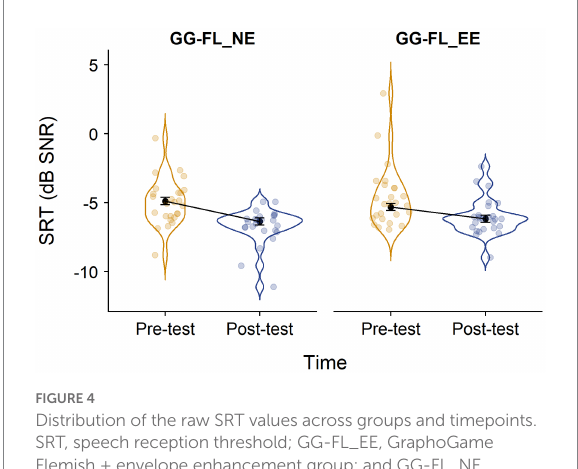
FIGURE 4 Distribution of the raw SRT values across groups and timepoints. SRT, speech reception threshold; GG-FL_EE, GraphoGame Flemish + envelope enhancement group; and GG-FL_NE, GraphoGame Flemish + non-enhanced group. Black dots and error bars represent the model estimates and their standard errors, respectively.